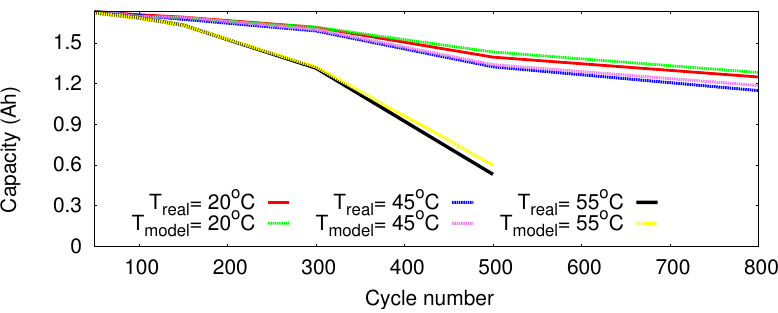
Figure 5. Battery cell long-term aging effect validation.